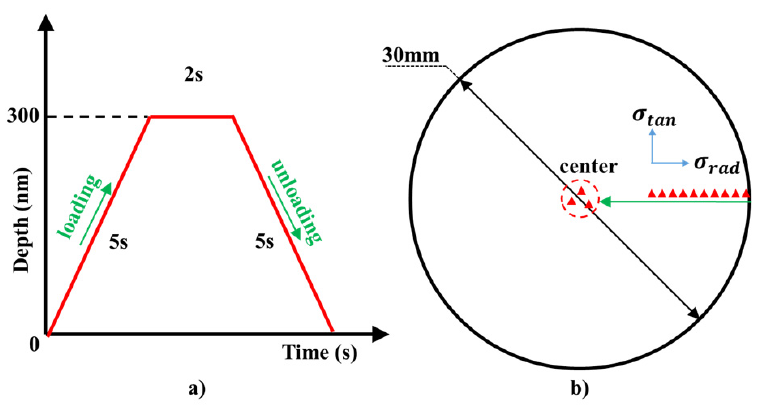
Figure 3. ( a ) Diagram of loading, pressure maintaining and unloading for the nanoindentation test; ( b ) illustration of the locations of the test points in the surface of a punched circular sample.